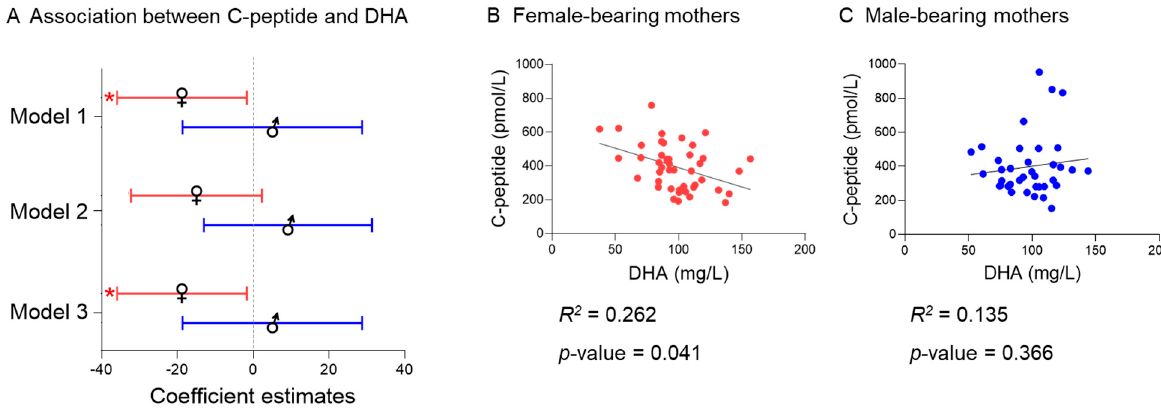
Figure 3. The association between C-peptide and docosahexaenoic acid is specific for female-bearing mothers. ( A ) Representation of the association between C-peptide and docosahexaenoic acid (DHA) in the female (n = 46) and male (n = 37) subgroups (Model 1: Adjusted for gestational age, maternal age and processing time, Model 2: Model 1 + Adjustment for BMI; Model 3: Model 1 + Adjustment for leptin). ( B ) Correlation between C-peptide and docosahexaenoic acid in the female subgroup. ( C ) Correlation between C-peptide and docosahexaenoic acid in the male subgroup. * Statistically significant difference after correction for multiple testing (FDR =